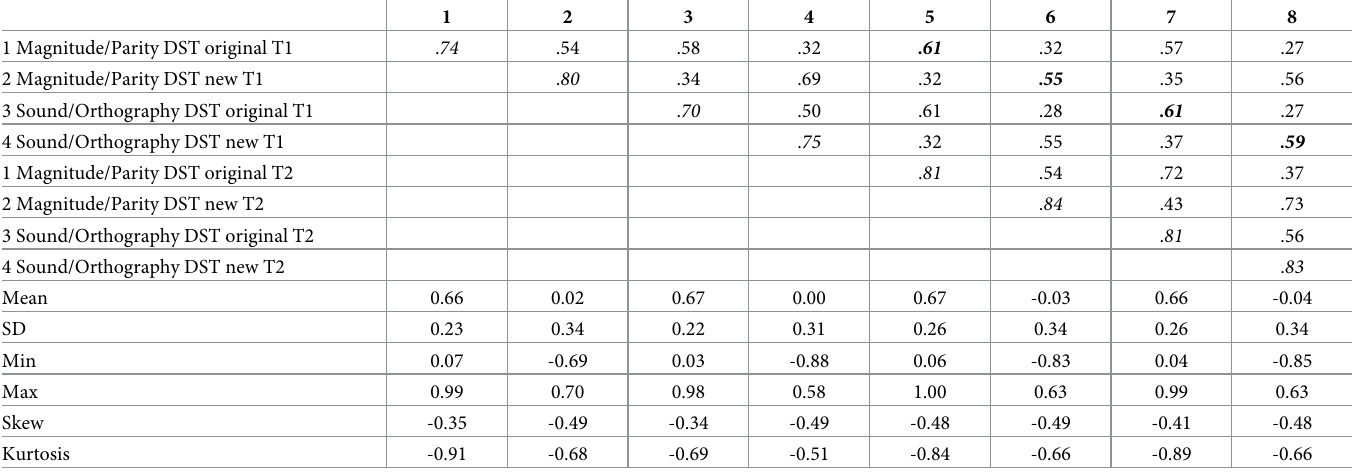
Table 2. Spearman correlations and descriptive statistics of demand avoidance